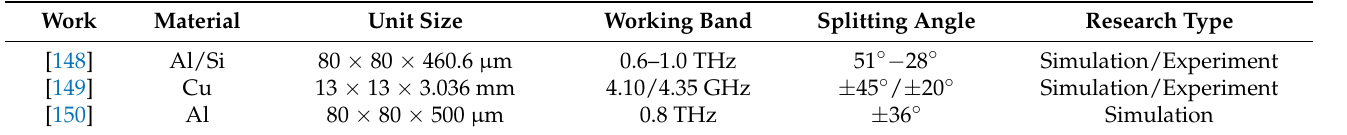
Table 10. Parameters of lighting control tunable metasurface beam splitters described in this